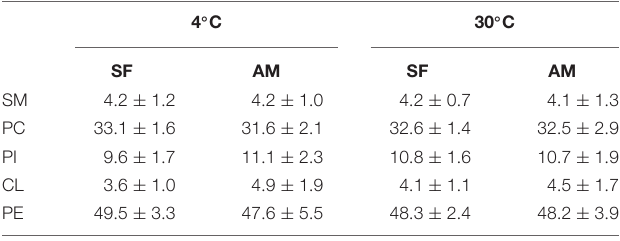
TABLE 2 | Proportions (%) of phospholipid classes including SM, sphingomyelin; PC, phosphatidylcholine; PI, phosphatidylinositol; CL, cardiolipin; and PE,